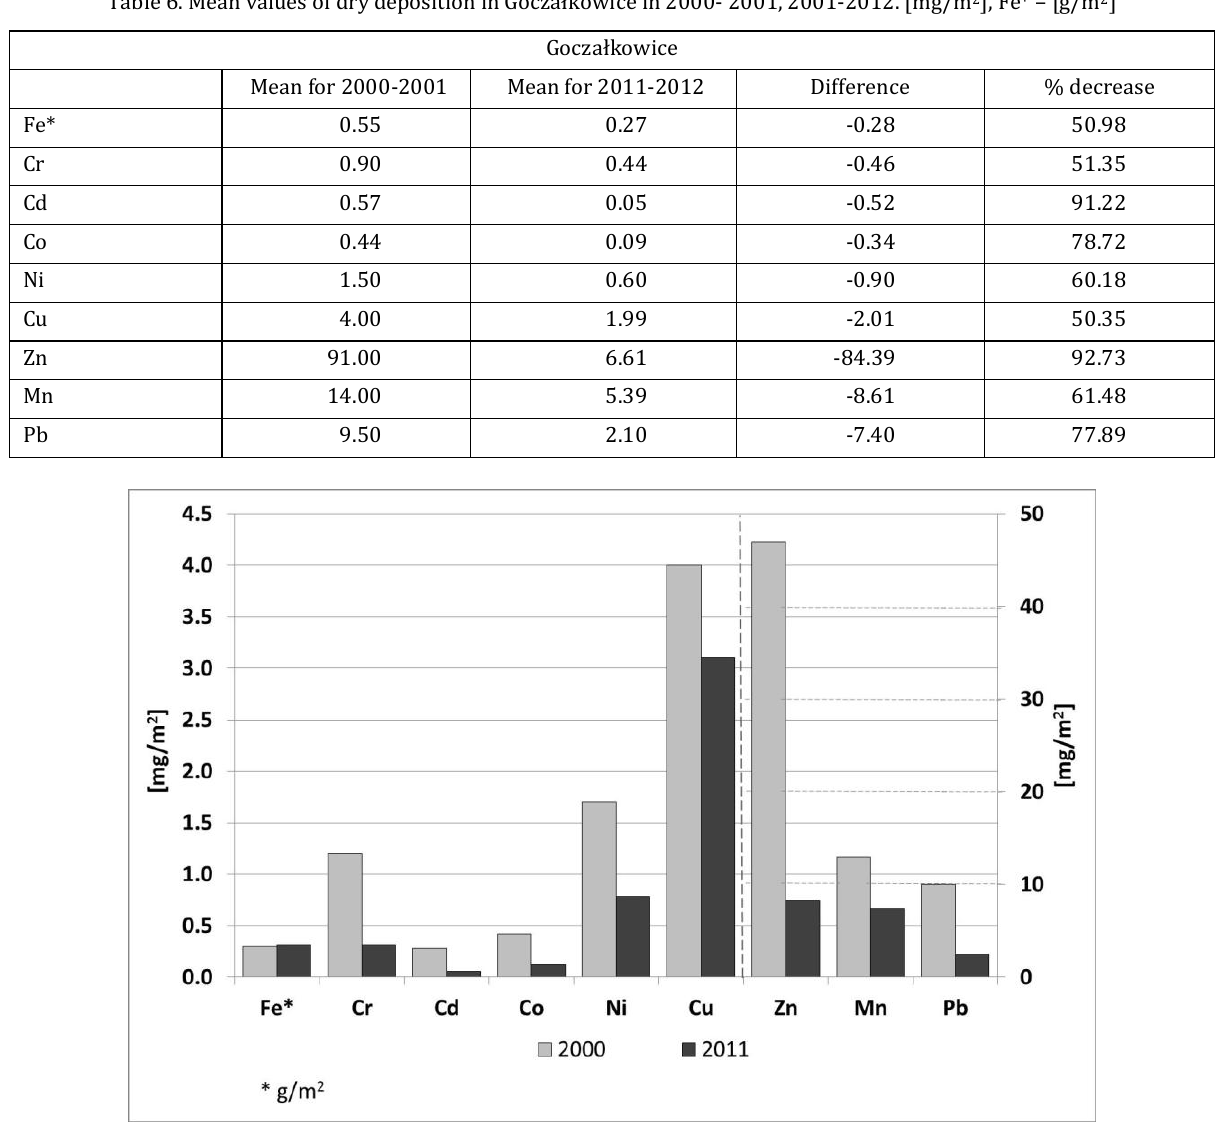
Fig. 12. Mean annual dry deposition values for the selected metals in Goczałkowice in 2000 and 2011 in [mg/m 2 ], Fe* – [g/m 2